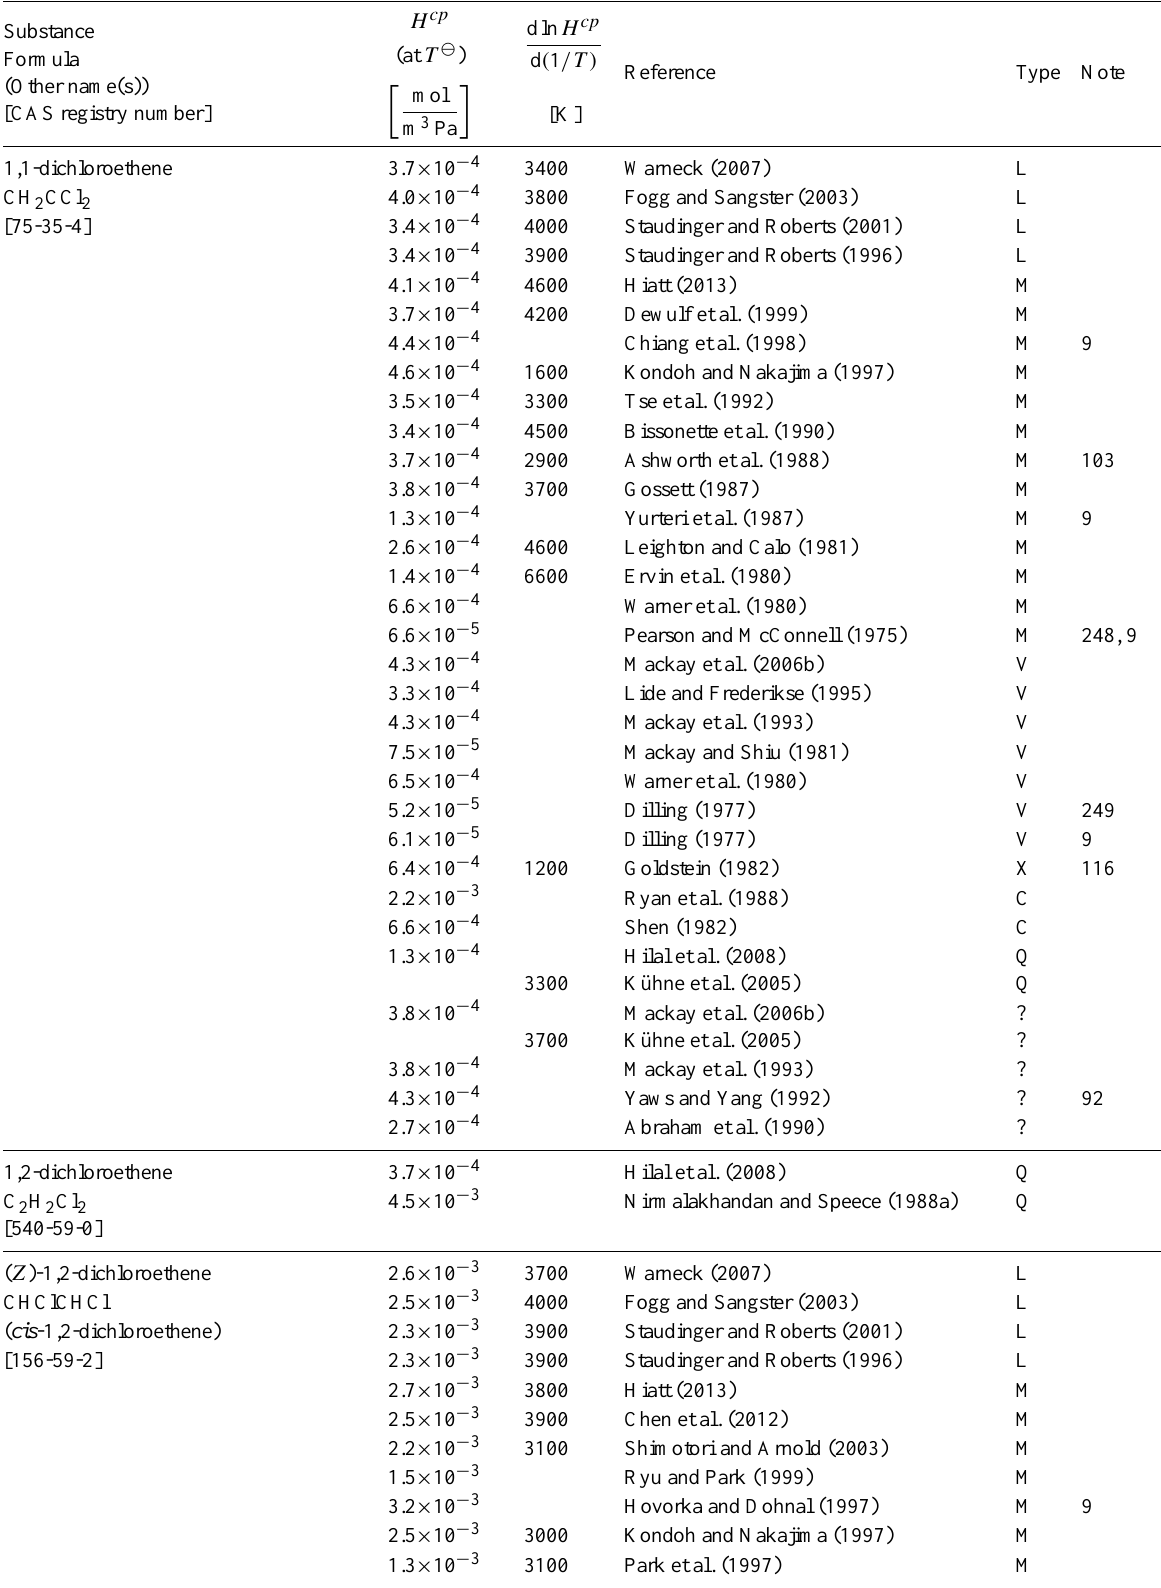
Table 6: Henry’s law constants for water as solvent